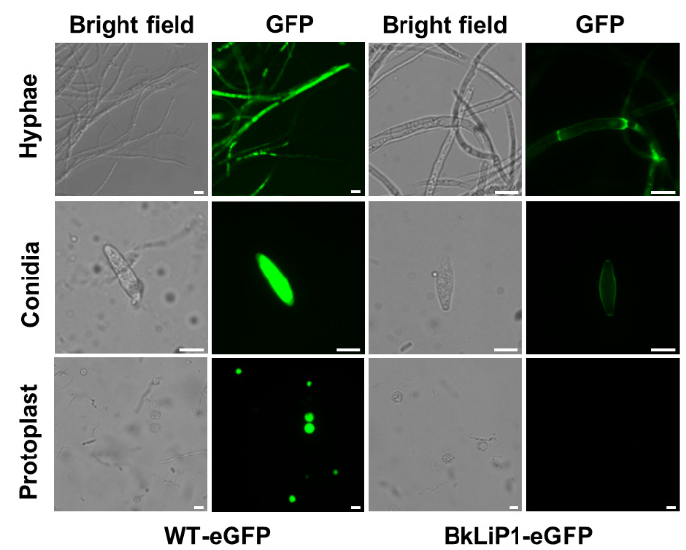
Figure 4. Localization analysis of BkLiP1 in B. kuwatsukai . Localization of eGFP and fusion protein BkLiP1-eGFP in the hyphae, conidia, and protoplast of B. kuwatsukai observed under a fluorescence microscope. Scale bar = 10 µm.